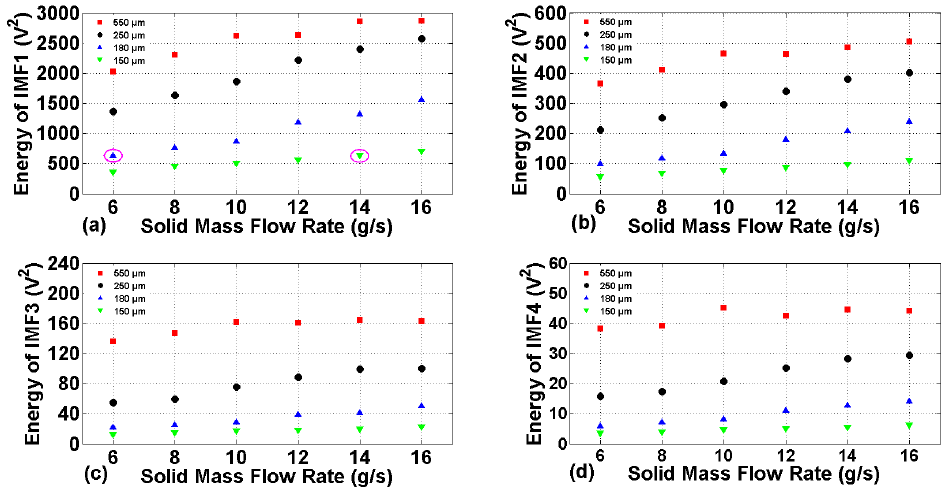
Figure 12. Relationship between IMF energy and particle mass flow rate for different particle sizes.